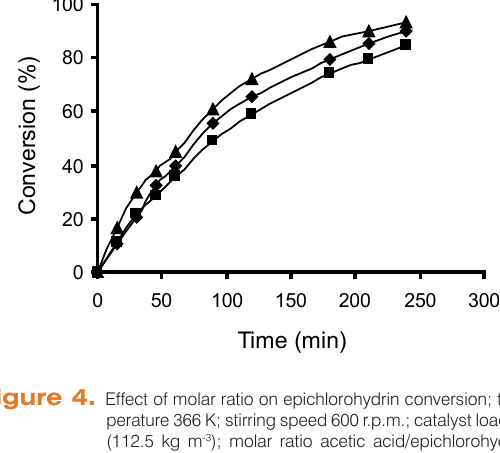
Figure 3. Effect of molar ratio on acetic acid conversion; tempera - ture 366 K; stirring speed 600 r.p.m.; catalyst loading (112.5 kg m -3 ); molar ratio acetic acid epichlorohydrin: ♦ 1:2 ; ■ 1:1.5 ; ▲ 1:1.1 ; × 1:1.